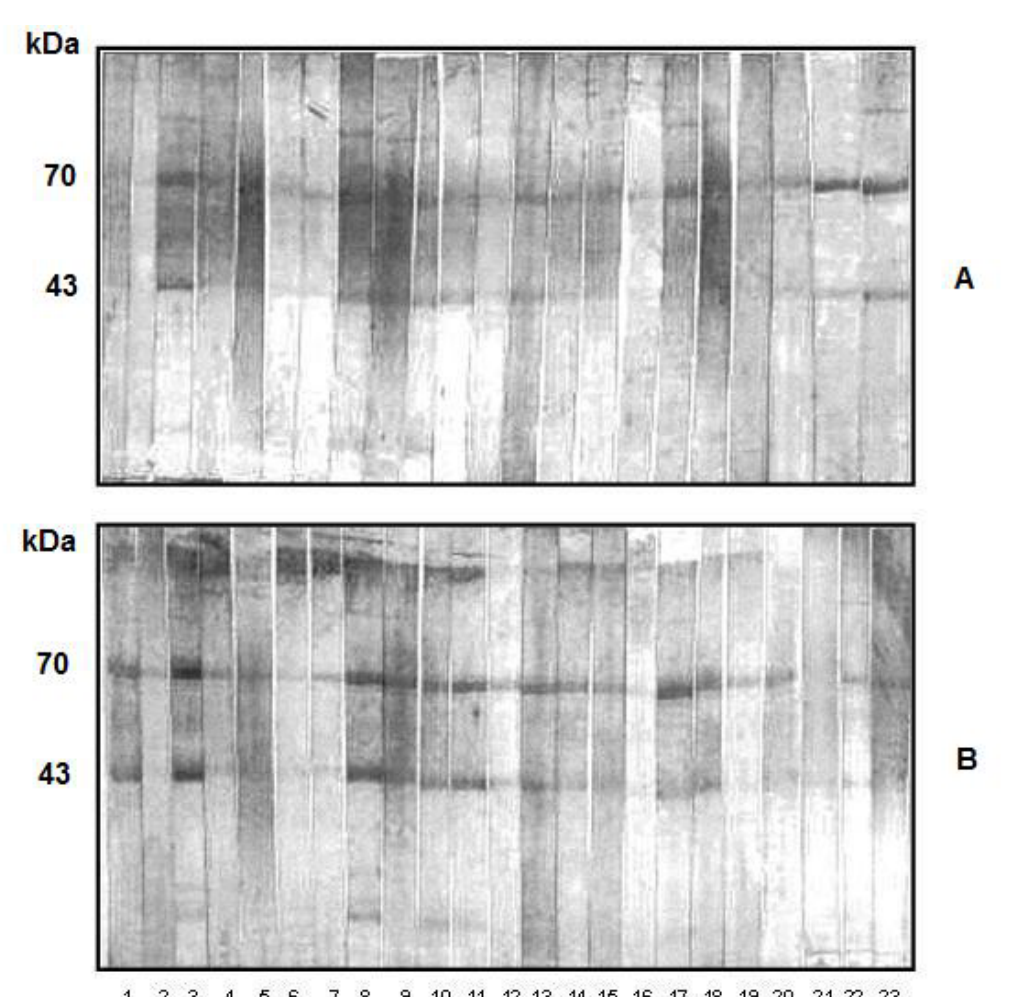
Figure 1. Antibody response to a soluble component of the cell wall outer surface of Paracoccidioides brasiliensis obtained on the 5 th (Panel A) and 10 th (Panel B) days of culture probed with 23 negative double immunodiffusion paracoccidioidomycosis sera samples (Lanes 1 to 23). Goat anti-human IgG serum conjugated with peroxidase was used as the second